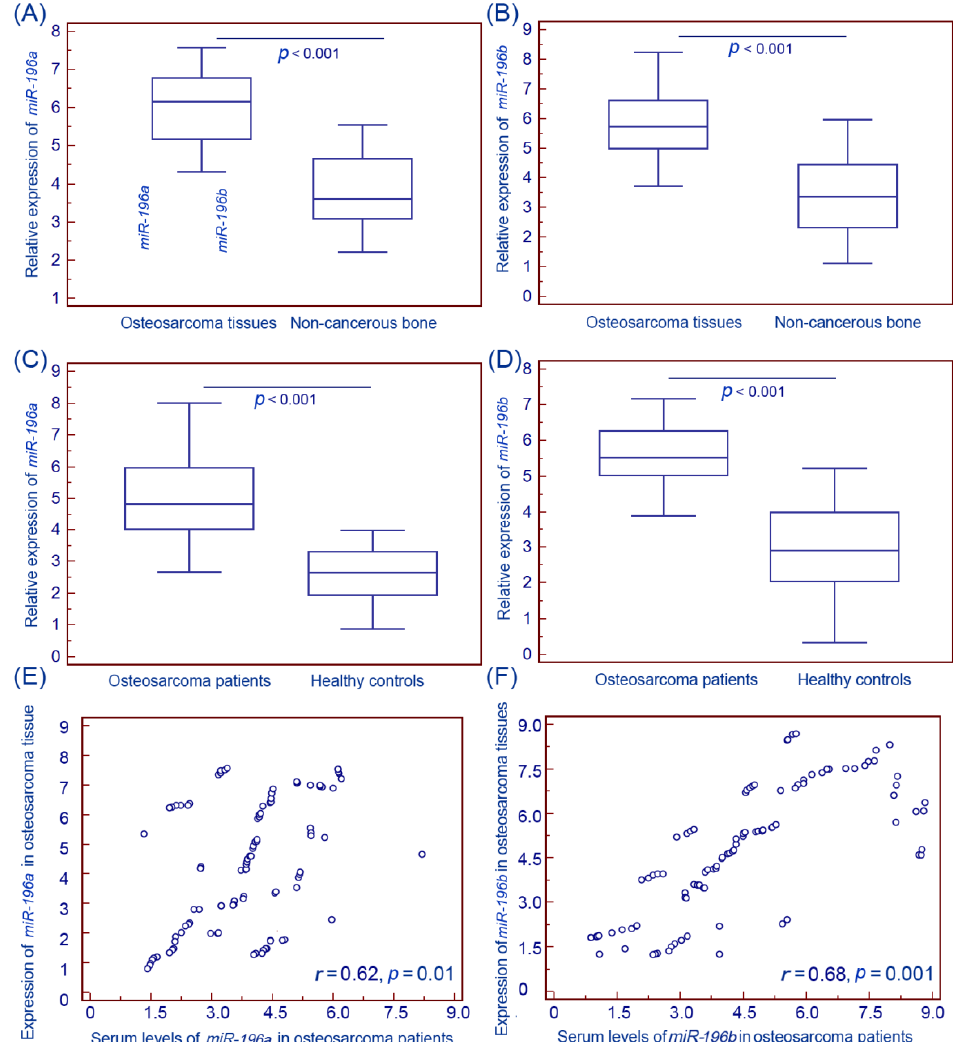
Figure 1. Expression levels of miR-196a and miR-196b in human osteosarcoma tissues and patients’ sera detected by qRT-PCR (Quantitative real-time reverse transcriptase-polymerase chain reaction) assay. The results showed that the expression levels of miR-196a ( A ) and miR-196b ( B ) in osteosarcoma tissues were both significantly higher than those in noncancerous bone tissues (both p < 0.001); Similarly, the serum levels of miR-196a ( C ) and miR-196b ( D ) were also markedly upregulated in patients with osteosarcomas compared with healthy controls (both p < 0.001); More interestingly, the expression levels of miR-196a and miR-196b in osteosarcoma tissues were both significantly correlated with those in patients’ sera (for miR-196a : Spearman’s correlation: r = 0.62, p = 0.01, ( E